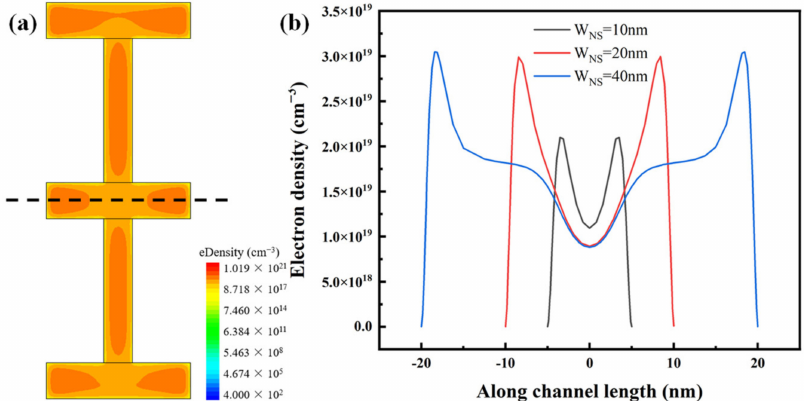
Figure 16. ( a ) Cutline of middle NS; ( b ) electron density along NS channel with different W NS at S NS = 20 nm and W IB = 4 nm when V GS = V DS = 0.7